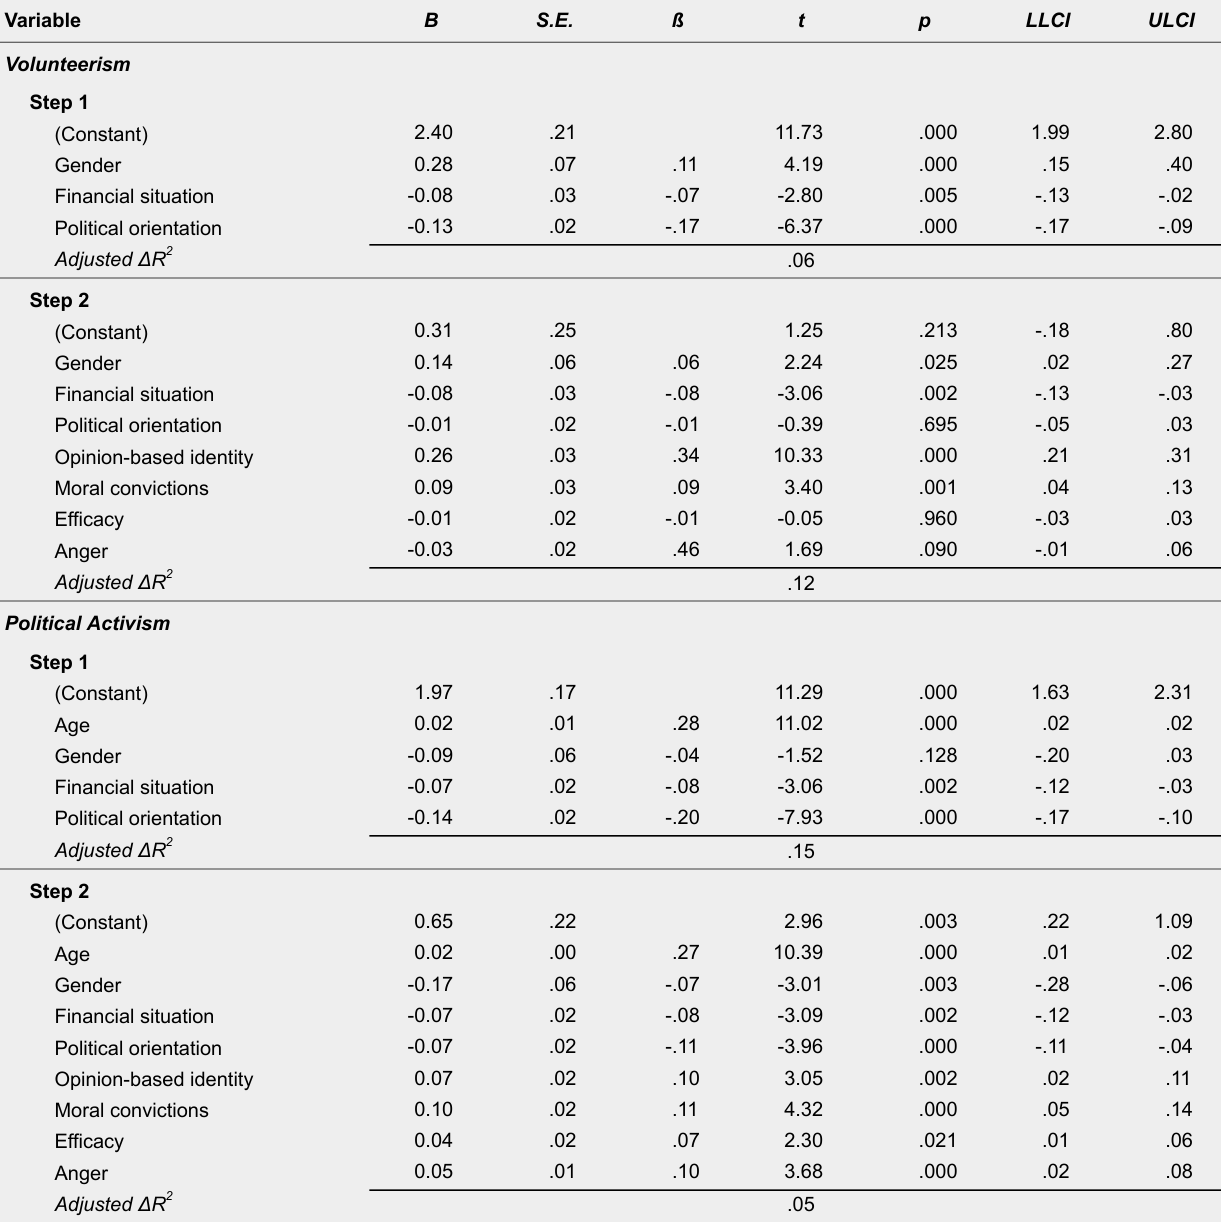
Hierarchical Regression Analysis With Volunteerism and Political Activism as Dependent Variables